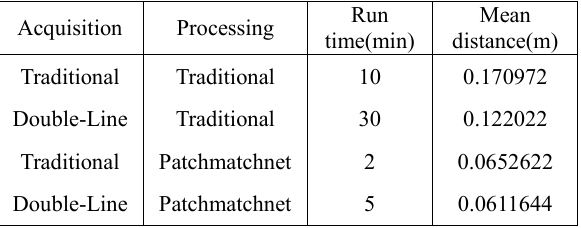
Table 2. Comparison of four experimental results.